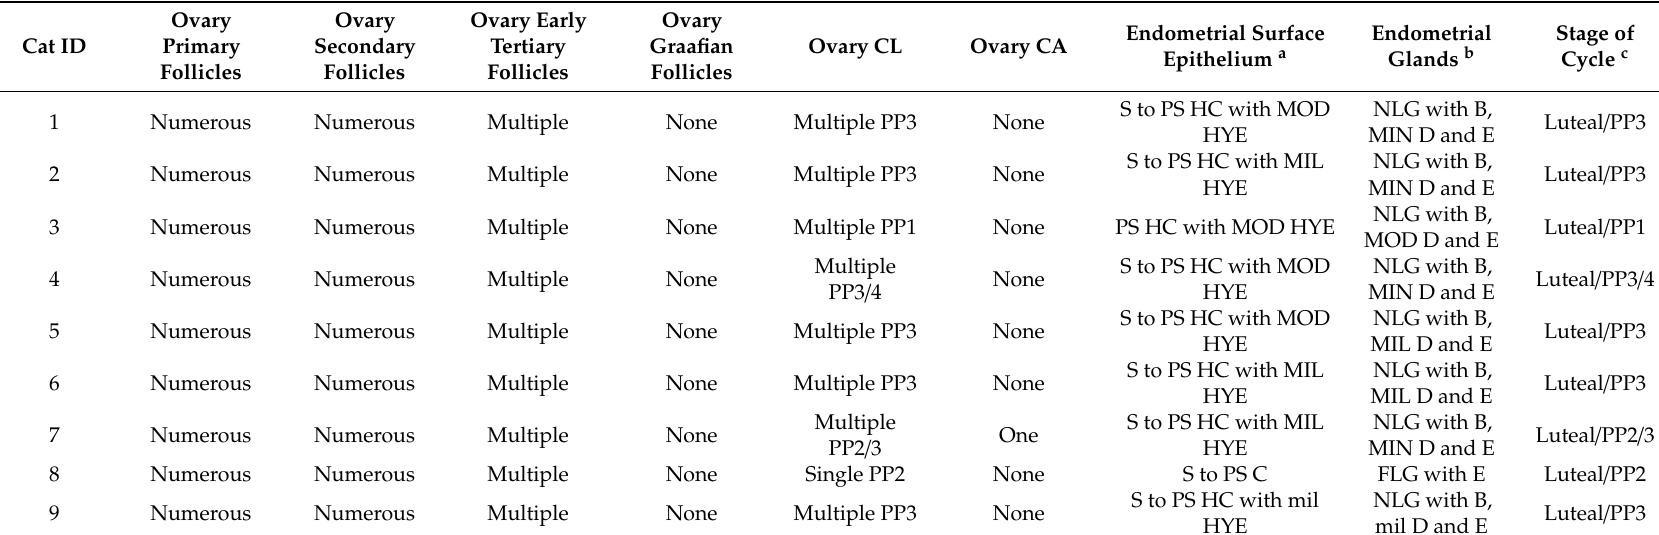
Table 4. Histological characterization and staging of ovaries and uterine